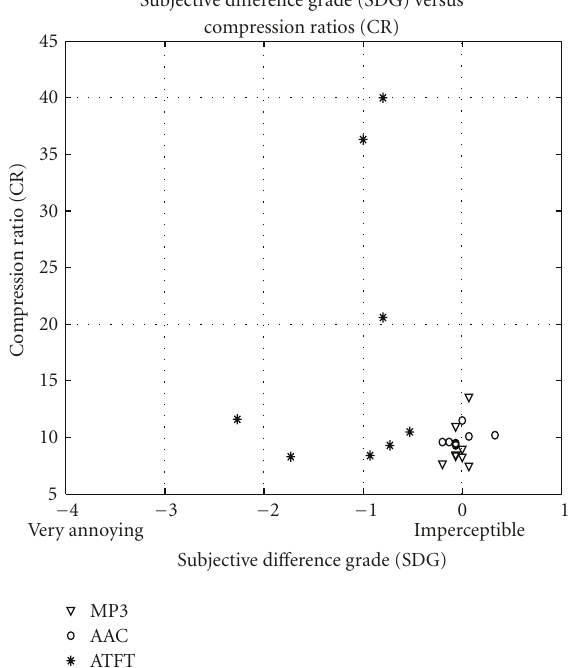
Figure 6: Subjective Di ff erence Grade (SDG) versus Compression ratios